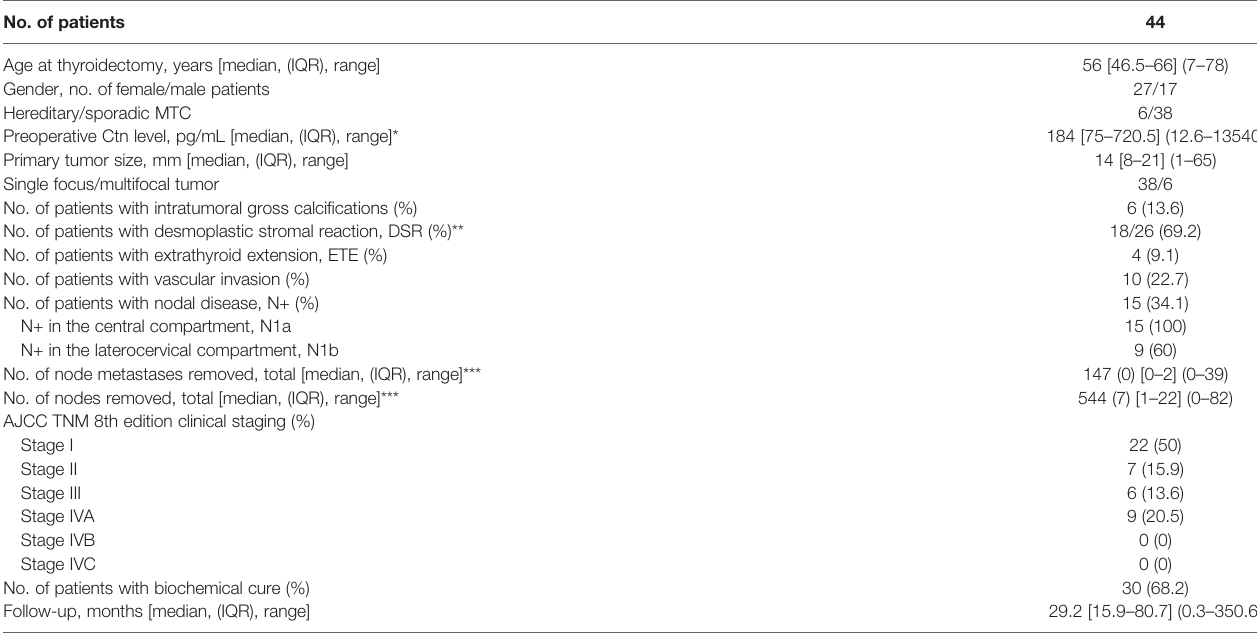
TABLE 1 | Clinical and histopathological characteristics of the study